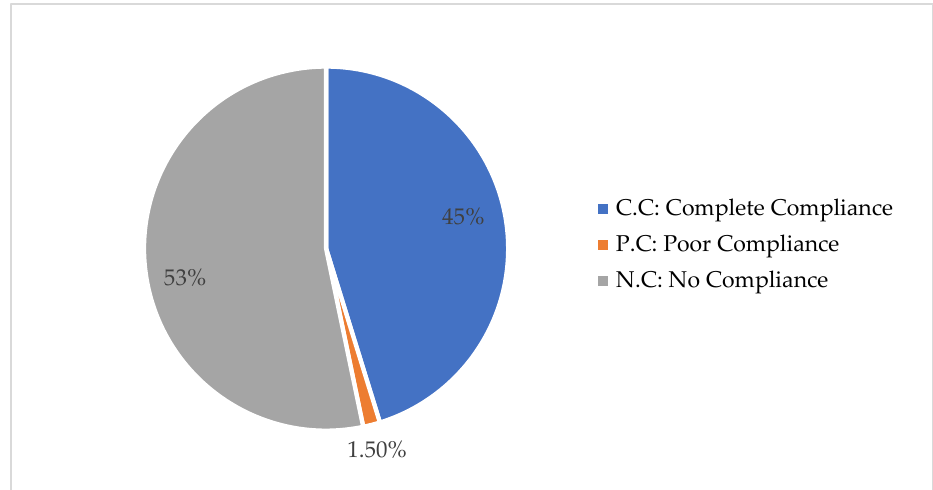
Figure 2. Distribution of the total selected drugs based on the GCC guidance and new templates from the SFDA (version 2.1 on 1 March 2021) for preparing PILs in Saudi Arabia.